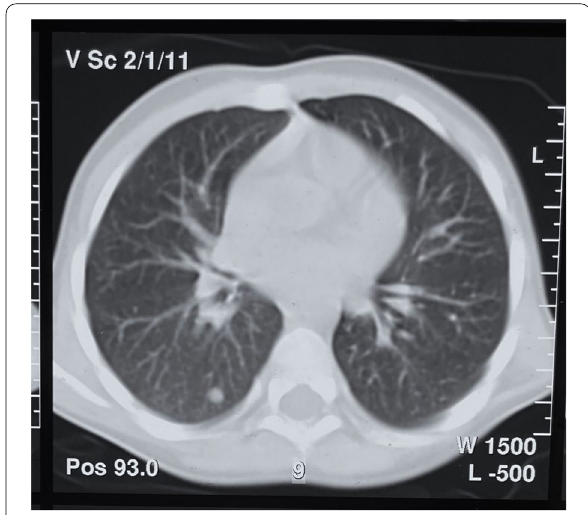
Fig. 2 CT Scan of the chest. A chest CT scan revealed a 6 mm nodule in the right